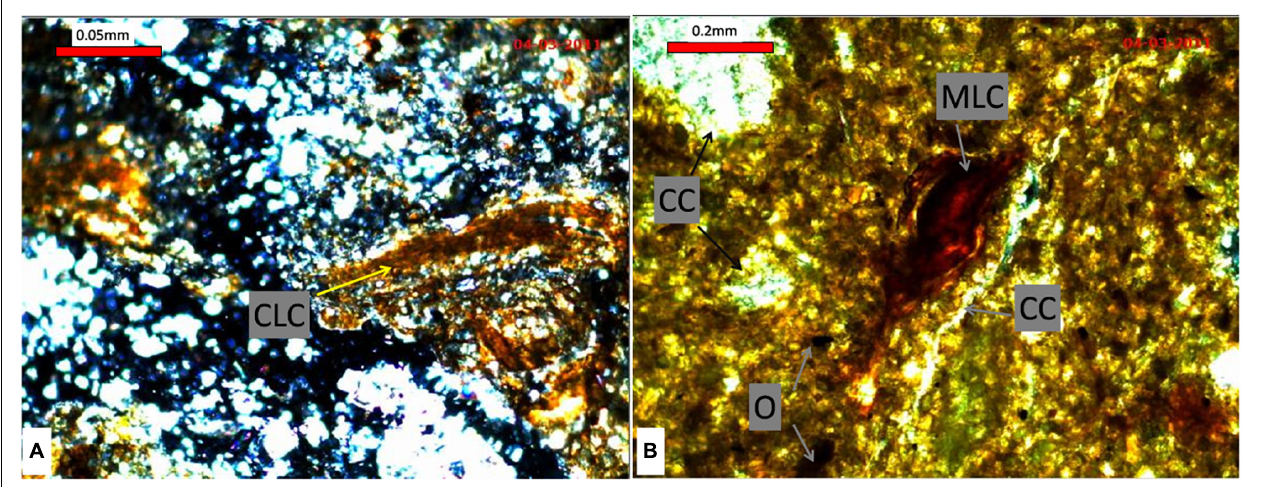
FIGURE 5 | Photomicrographs of the Khan Sahib section showing (A) clay coating (CLC) in a root cavity, quartz grains in a partly altered loess layer KS- L1 and (B) showing micro laminated clay coating (MLC), opaque minerals (O) channel and void filled with calcium carbonate (CC) in paleosol profile Btk (KS-S4) at the Khan Sahib (Dar et al.,